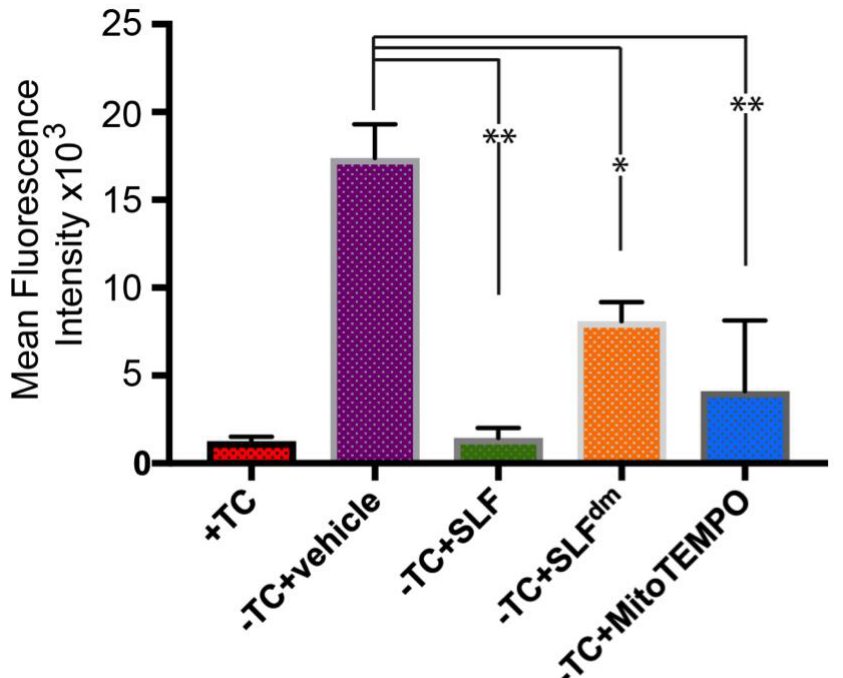
Figure 4. Quantification of mean fluorescence intensity signal of Aβ-induced ROS signal (see Figure 3) in human neuronal cells overexpressing the amyloid precursor protein (APP). The effect on Aβ-induced ROS signal of SLF, SLF dm , and MitoTEMPO addition to the APP-induced cells (−TC) is given by the green, orange, and blue bars, respectively, and is compared to the −TC group. Statistical analyses of fluorescence intensity by one-way ANOVA gives * p < 0.01, ** p < 0.001 for n = 3. Error bars represent the standard error as described in the Methods section.